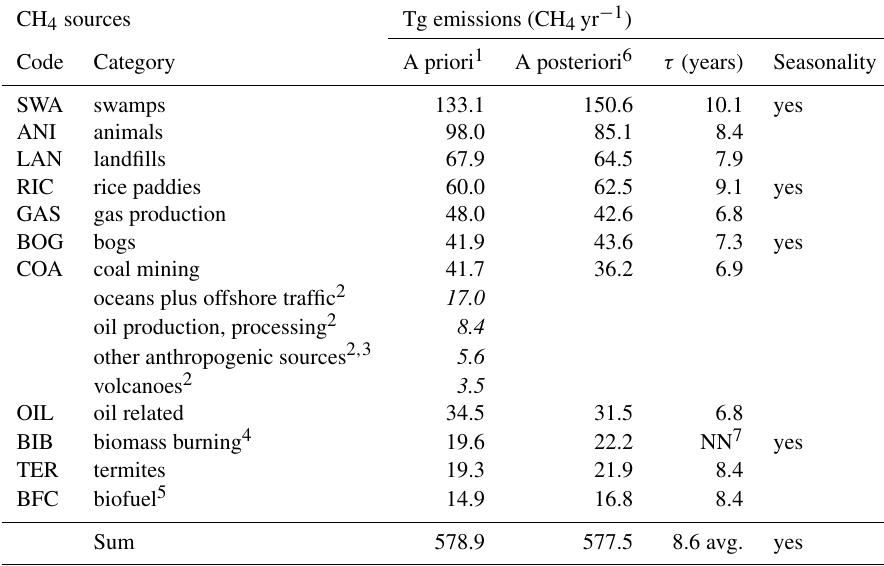
Table 1. Methane emissions from eleven sectors: annual amounts and lifetime τ